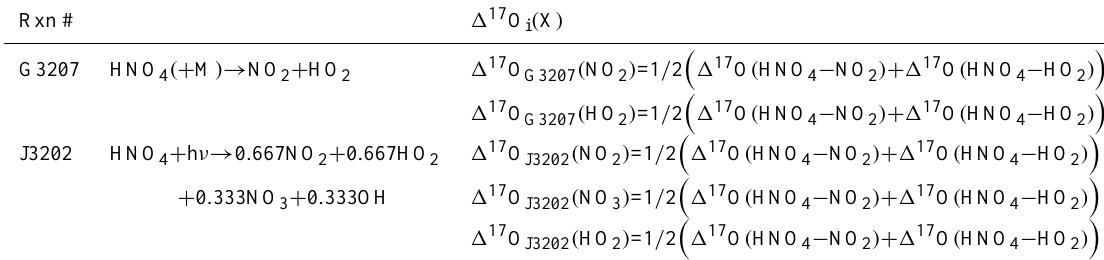
Table 4. 1 17 O i ( X ) for Case 5: Scrambling upon thermal decomposition and photolysis of HNO